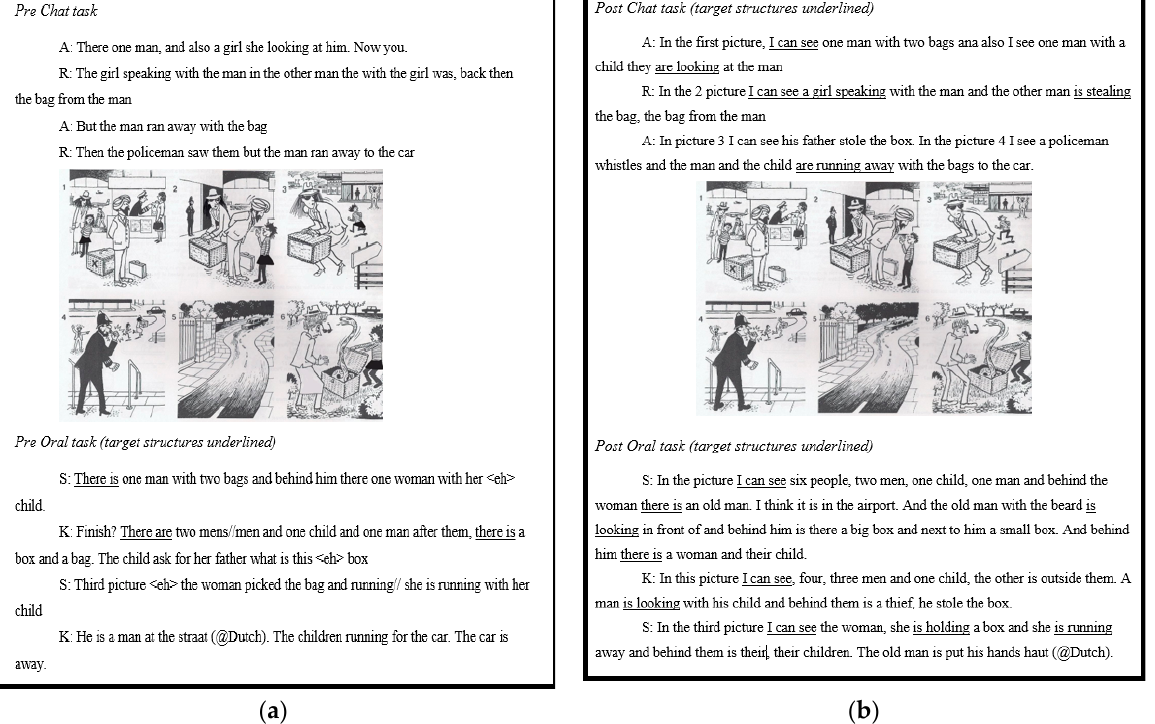
Figure 1. ( a ) Examples of pre-test oral and chat task performance, ( b ) examples of post-test oral and chat task performance.